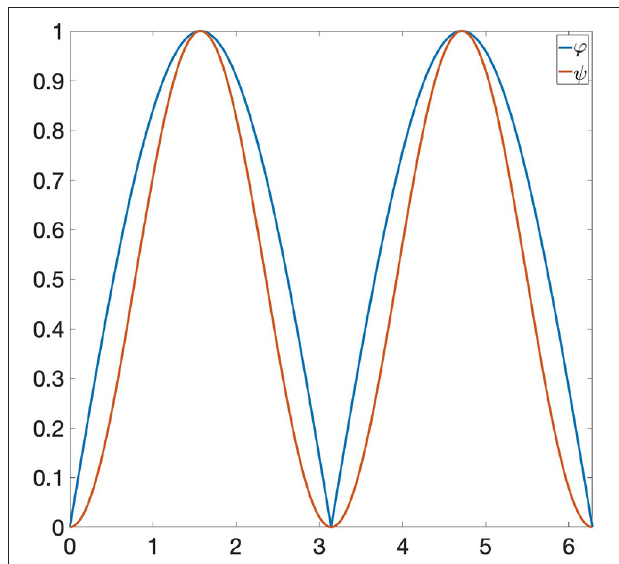
FIGURE 1 | The functions ϕ and ψ have the same persistence